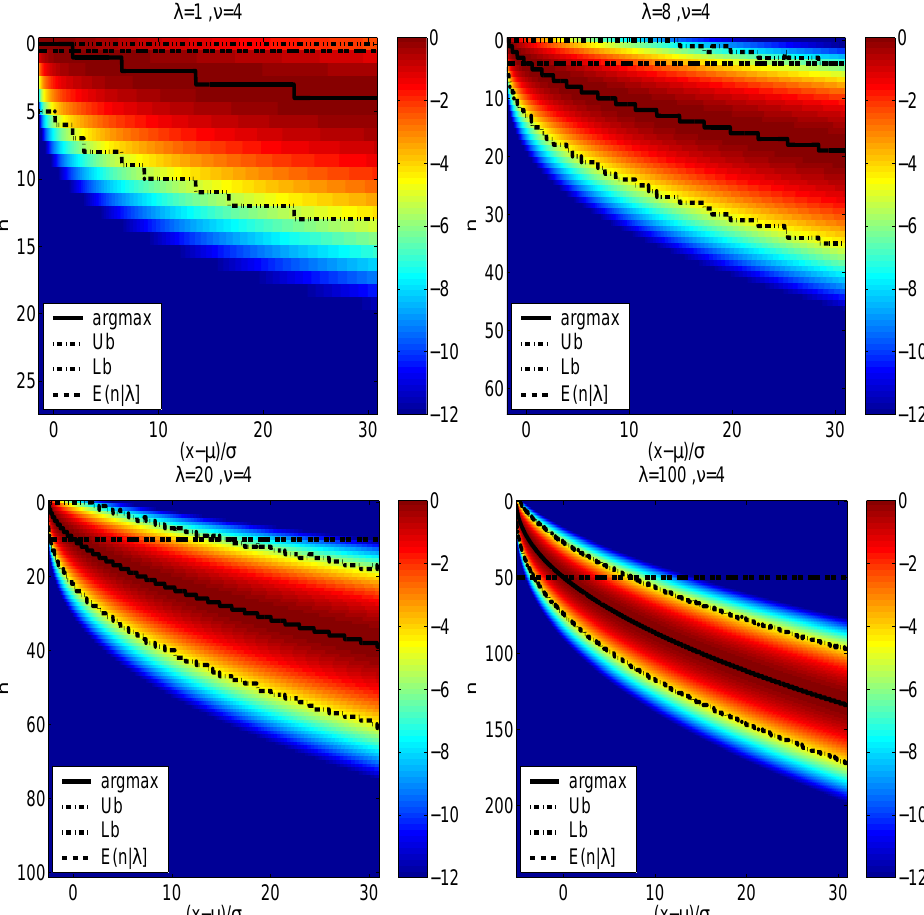
Figure 1. The magnitude of the normalized terms r ( x, n | λ , ν ) for ν = 4 . The peak is shown as a function of x for various non-centrality parameters λ . The difference between (cid:98) λ / 2 (cid:99) f ( x, n | λ , ν ) in the tail regions is apparent. The upper (Ub) and the actual n ∗ = argmax n and lower (Lb) bounds of Algorithm 3 for the interval of summation associated with B = 4 decimal place accuracy.